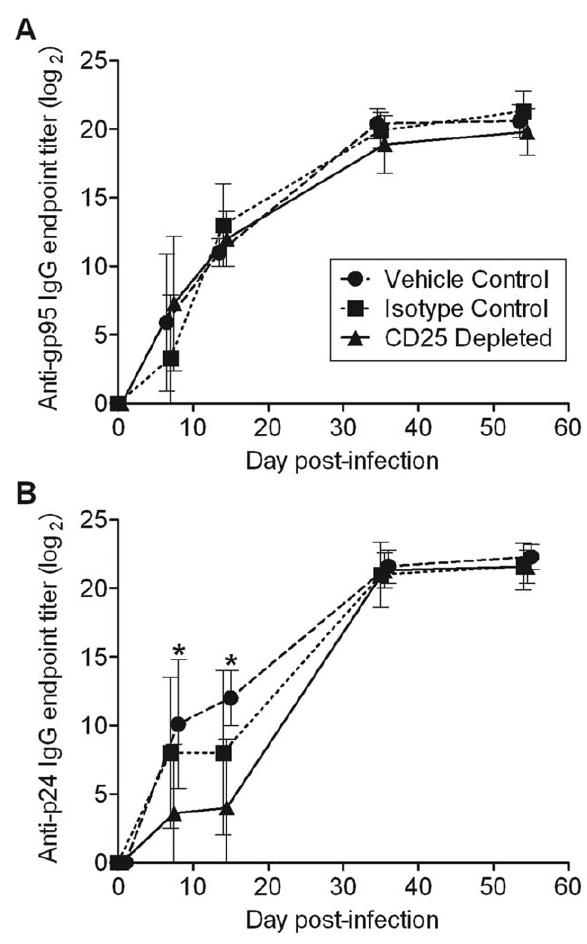
Figure 8. Anti-FIV p24, but not anti-FIV gp95, IgG titers are significantly lower after anti-CD25 mAb treatment during acute FIV infection. (A) Anti-FIV gp95 and (B) anti-FIV p24 IgG titers were quantified in serum samples on days 0, 7, 14, 35, and 54 post-FIV infection. Positive antibody titers were calculated based on a 3-fold higher optical density than day 0 pre-inoculation controls. Mean 6 SEM is shown. Statistical significance was determined between treatment groups for each time point (n=8/group). * indicates p ,